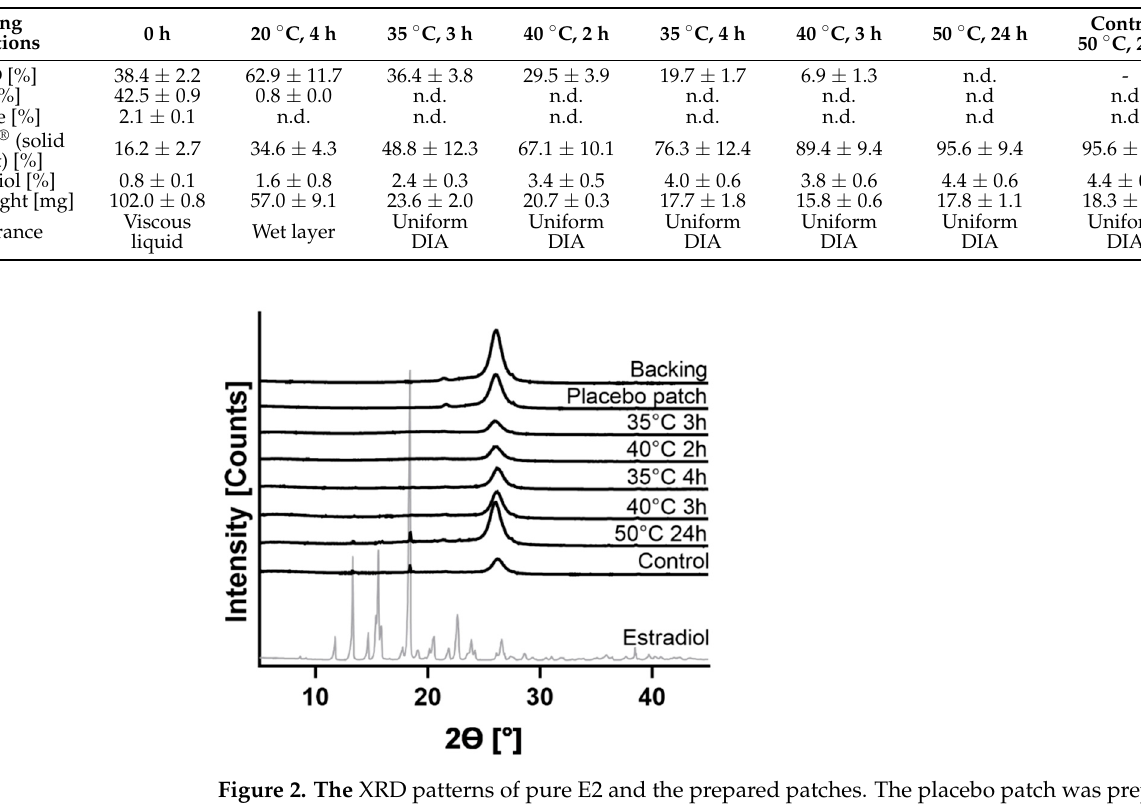
°C, 3 h) was four times higher than of 50 °C, 24 h (Table 2). The highest mean dose deliv- ered was 82 µg/24 h (35 °C, 3 h), the lowest for 50 °C, 24 h and control were 26 µg/24 h and 24 µg/24 h, respectively. Lag times increased with increasing DMSO content in the patches. Table 2. Flux values, lag time, mean delivered dose and kinetic release rate of the prepared patches. Drying Conditions 35 °C, 3 h 40 °C, 2 h